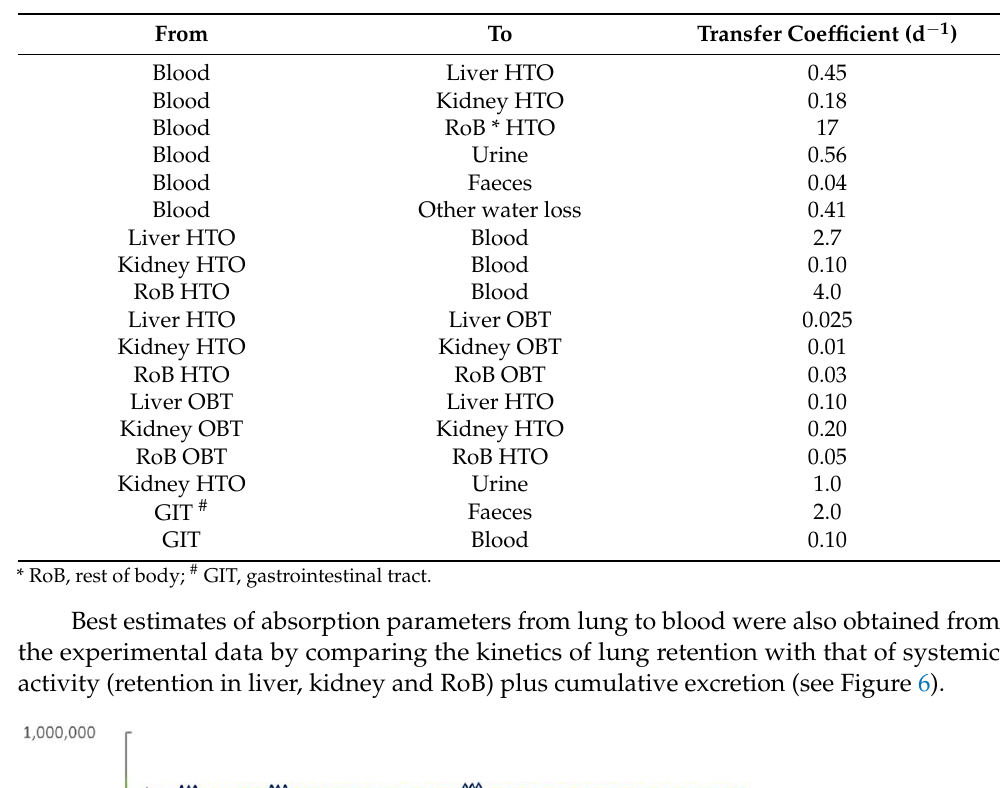
Table 3. Systemic transfer rates of the rat biokinetic model for inhalation of tritiated steel particles.